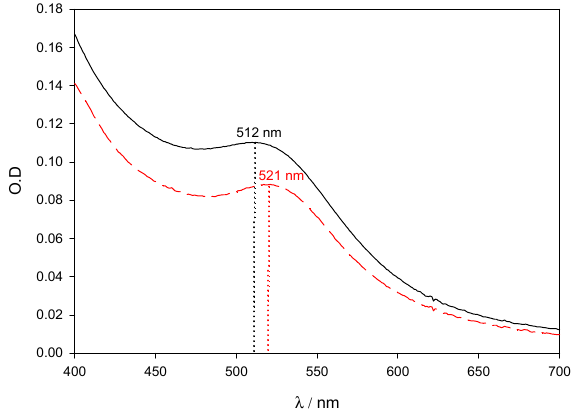
Figure 1. Experimental spectra of AuNPs solutions on the visible region. Commercial gold nanoparticles were used as received. Black solid line corresponds to 4.8 nm AuNPs and gold concentration of 67 µg/mL. Red dashed line corresponds to 5.1 nm AuNPs and gold concentration of 45 µg/mL.